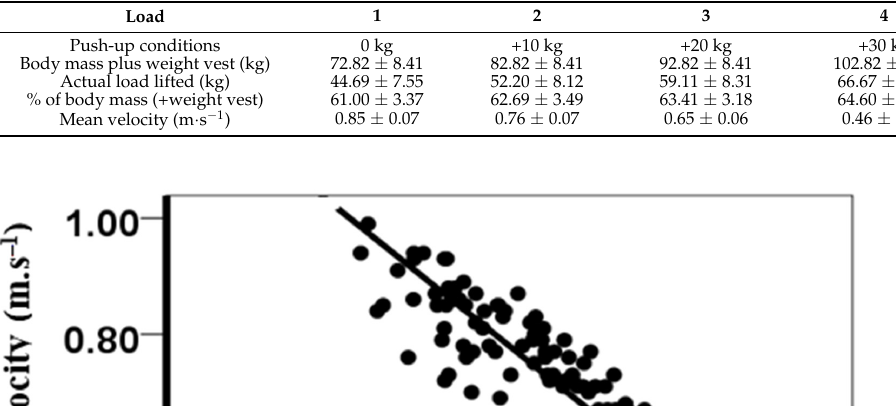
Figure 3. Relationship between swimming performance and the calculated predicted 1-RM push-up. FC: front crawl.